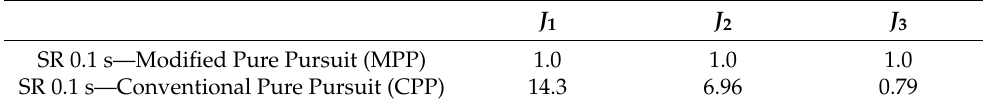
Table 1. Cost index results for Pure Pursuit